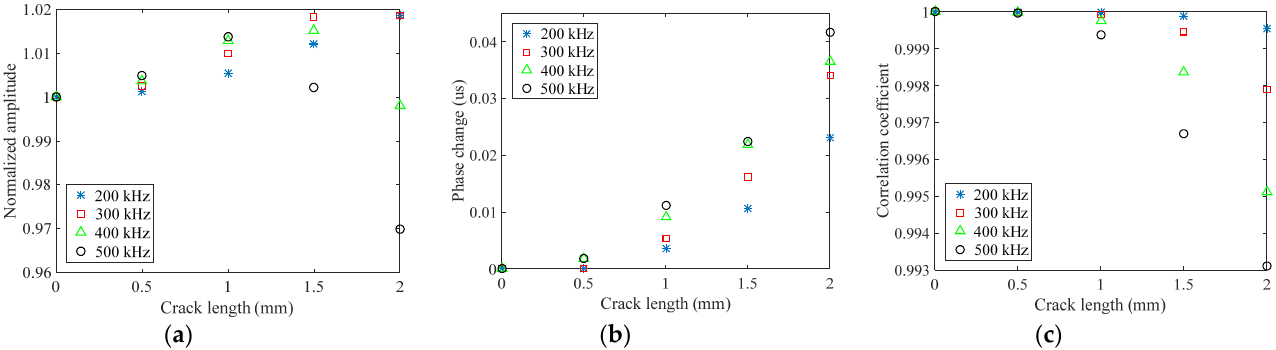
Figure 7. Crack length versus damage features of GCC signals: ( a ) normalized amplitude; ( b ) phase change; ( c ) correlation coefficient.